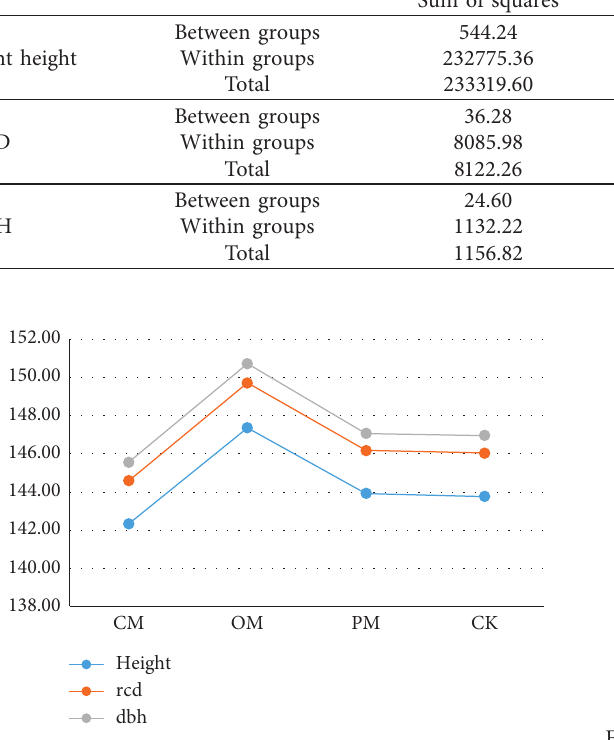
Figure 2: Plant height, root collar diameter (RCD), and diameter at breast height (DBH).